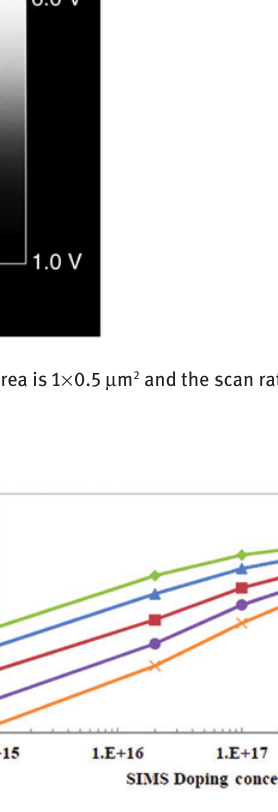
Figure 12: Five SCM calibration curves obtained at different AC tip biases (0.5, 0.75, 1.0, 1.25, and 2.0 V), correlating the SCM